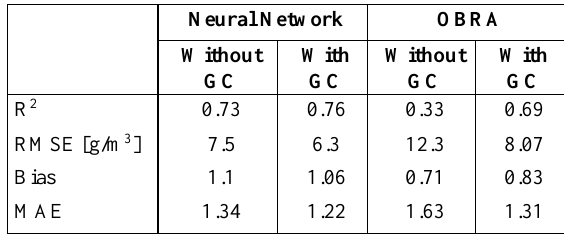
Figure 6 . Matchup validation of neural network-based TSM retrieval to assess the temporal transferability of the model (a) without and (b) with sun glint correction.